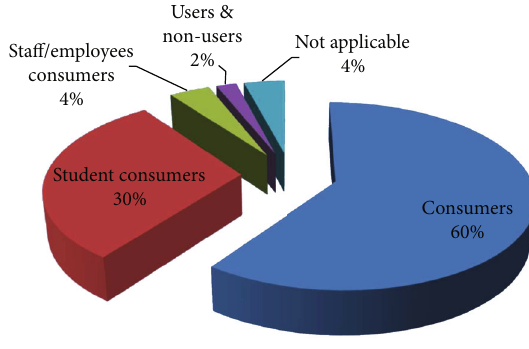
Figure 8: Sample source of online consumer behavior